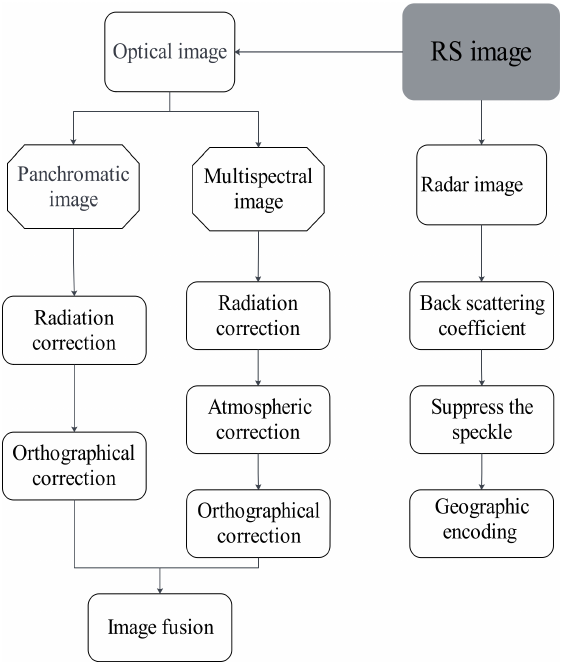
Figure 2. Processing flow chart of RS